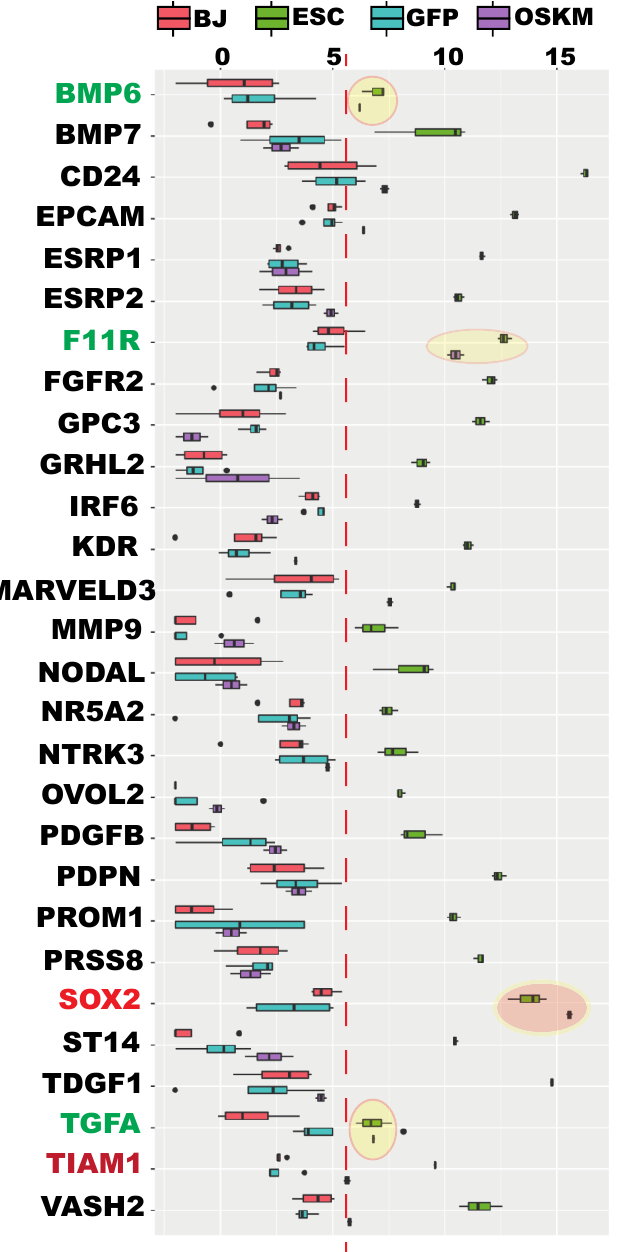
Figure 7. The hPSC-specific epithelial genes were not reprogrammed at the time of proper RB reprogramming. Box plots for each individual gene showing lack of reprogramming of the genes indicated, except for SOX2 , TGFA , BMP6 , and F11R . High level of SOX2 was from the lentiviral transgene; TGFA and BMP6 were properly reprogrammed to the pluripotency levels; F11R was upregulated significantly but insufficiently. See also Supplementary Figures S16 and S17.